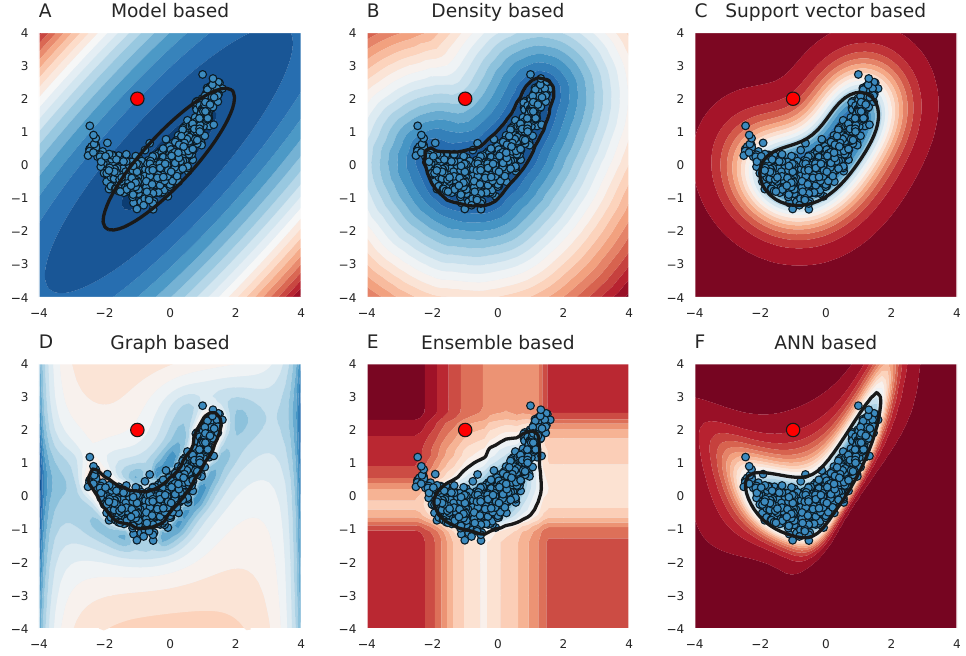
Figure 1. Outlier detection methods try to establish a boundary around the normal samples. Outlier methods are presented with a set of normal samples and extracted from a boundary around them. Distances to this boundary then give an impression of how aberrant a sample is with respect to the set of normal samples. Here, six different outlier methods are shown that are based on distinct approaches. The normal samples on which the outlier methods are trained are presented as blue dots in the plots. The boundary is depicted with the black line and outlier scores (to the boundary) are colored using a heatmap. As an example, one outlier sample is shown, the red dot. The different figures show that different methods use different assumptions with respect to the distribution of the normal samples. As a result, some methods are able to accurately follow the shape of the normal data, whereas other methods find it harder to establish an appropriate boundary. Note that in these illustrations, only two features are considered. ( A ) Model based outlier detection. ( B ) Density based outlier detection. ( C ) Support vector based outlier detection. ( D ) graph based outlier